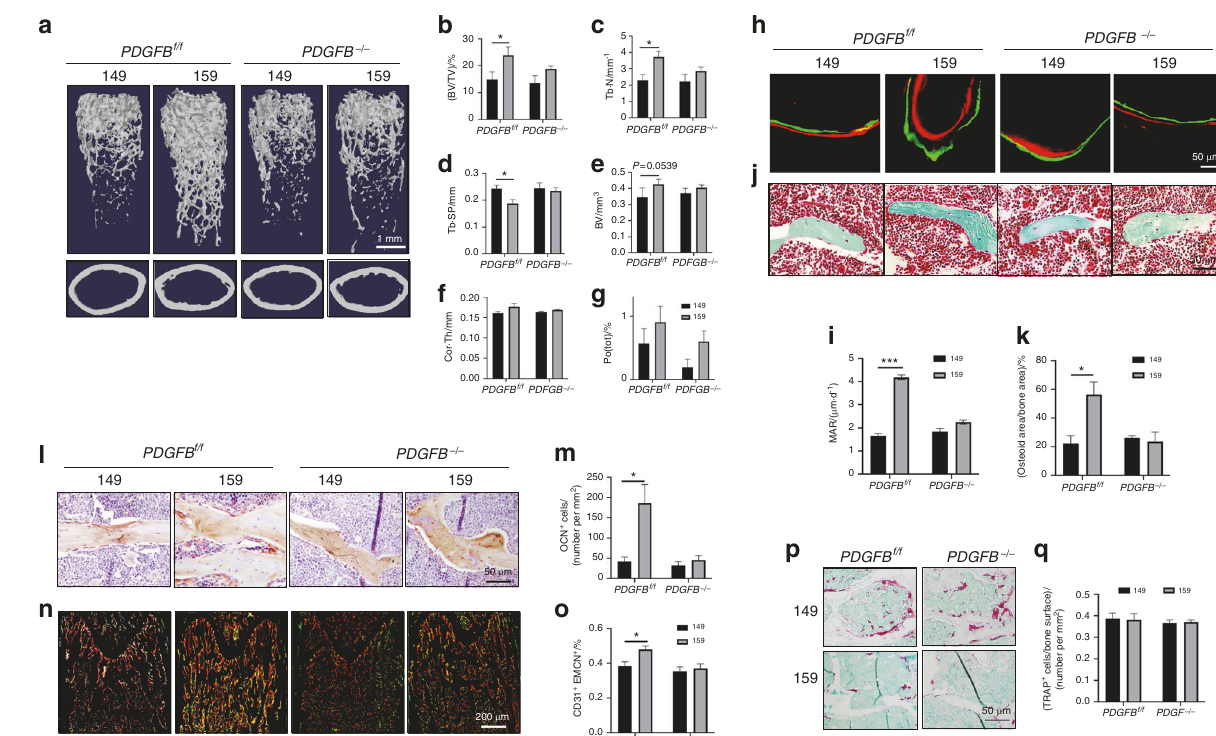
Fig. 5 Knockout of PDGF-BB in the osteoclast lineage blunted the effect of the Siglec-15 neutralizing antibody on bone formation. All data in this fi gure are derived from 5-month-old PDGFB f/f or PDGFB − / − mice treated with NP-149 or NP-159 for 2 months. a Representative three-dimensional µCT images of the mouse femurs. Quantitative analysis of the µCT scan in a : b BV/TV percentage trabecular bone volume, c Tb. N trabecular number, d Tb. Sp trabecular separation. e BV cortical bone volume, f Cor. Th cortical bone thickness, and g Po (tot) total porosity of cortical bone. n = 5, * P < 0.05. h Double labeling of the mineral layers in mouse femur trabecular bone. i Quantitative analysis of the mineral apposition rate in h . n = 5, *** P < 0.001. j Trichrome staining of mouse femurs. The osteoid layer is labeled red. k Quantitative analysis of the osteoid-covered surface in p . n = 5, * P < 0.05. l Representative images of immunohistological staining of osteocalcin in the distal femurs. m Quantitative analysis of osteocalcin staining in l . n = 5, * P < 0.05. n Co fl uorescence staining of CD31 (green) and endomucin (EMCN) (red) in mouse femurs. o Quantitative analysis of the ratio of CD31 and EMCN double-positive fl uorescence intensity in n . n = 5, * P < 0.05. p Representative images of TRAP staining of the distal femurs. q Quantitative analysis of TRAP staining in p . The number of TRAP + cells was normalized to the bone area. n = 5 on the bone surface was higher in the mice treated with NP-158 or different Fc domains (NP-158 and NP-159) and used NP-149-treated NP-159 than in the NP-149-treated mice (Fig. 6m – o). Our fi ndings mice as the controls. We administered the Siglec-15 antibodies NP- show that the neutralizing antibody against Siglec-15 effectively 159, NP-158, or NP-149 twice weekly for 8 weeks to 3-month-old prevents estrogen depletion-induced bone loss in adult female mice. female C57/bl6 mice that underwent OVX or sham surgery. μ CT analysis showed that OVX-induced estrogen de fi ciency resulted in Injection of the Siglec-15 neutralizing antibody promoted fracture signi fi cant bone loss in the NP-149-treated mice. This pathological healing change was prevented by NP-158 or NP-159 treatment. Adminis- Fracture is the major consequence of osteoporosis, and reunion of tration of both NP-159 and NP-158 signi fi cantly increased the BV/TV the cortical bone is the primary sign of fracture healing. Currently, no and Th. N values in the sham-operated and ovariectomized mice medication effectively promotes cortical bone formation. A previous compared with the NP-149-treated mice (Fig. 6a – c). A signi fi cant study showed that the number of TRAP + cells in the periosteum is difference in Th. Sp was found between the OVX mice treated with NP-149 and those treated with NP-158 or NP-159 (Fig. 6a, d). The signi fi cantly lower in adult mice (3 and 6 months old) than in young effect of NP-158 in increasing bone density seemed to be slightly mice (0.5 and 1 month old). 21 This mechanism may be the reason for stronger than that of NP-159, but there was no signi fi cant the high number of nonunions in elderly patients with osteoporosis- difference between these two groups. The effects of both NP-158 related fractures. We tested whether the Siglec-15 neutralizing and NP-159 on cortical bone did not achieve a signi fi cant difference antibody can rejuvenate the bone-forming capacity of the compared to that of the NP-149-treated groups (Fig. 6a, e, f). Similar periosteum by increasing the number of premature osteoclasts to that in the SKO mice, the ratio of mononuclear TRAP + immature and, subsequently, PDGF-BB production. We tested our hypothesis in two types of bone healing mouse models. In the fi rst model, a osteoclasts to multinuclear mature osteoclasts in the trabecular area transcortical hole was created using a microdrill at the midsheaf of was signi fi cantly higher in the NP-159- and NP-158-treated sham- the femur, which mimics damage caused by the screw of an external operated or OVX mice than in the NP-149-treated mice (Fig. 6g – i). fi xator (Fig. S2). In the second model, a semiosteotomy was Double immuno fl uorescence staining of TRAP and PDGF-BB performed at the midshaft of the mouse femurs, which resembled showed that treatment with NP-158 or NP-159 increased the the clinical fracture healing process (Fig. 7). We started the 4-week number of cells that were double-positive for TRAP and PDGF-BB in treatment immediately after surgery. In both mouse models, we both the sham-operated and OVX groups; however, only the NP- compared the therapeutic effect of NP-159 with denosumab, the 159 group showed a signi fi cant difference when compared with the FDA-approved monoclonal antibody, on RANKL, and we used NP-149 group (Fig. 6j – l). As expected, the number of osteoblasts Bone Research (2021)